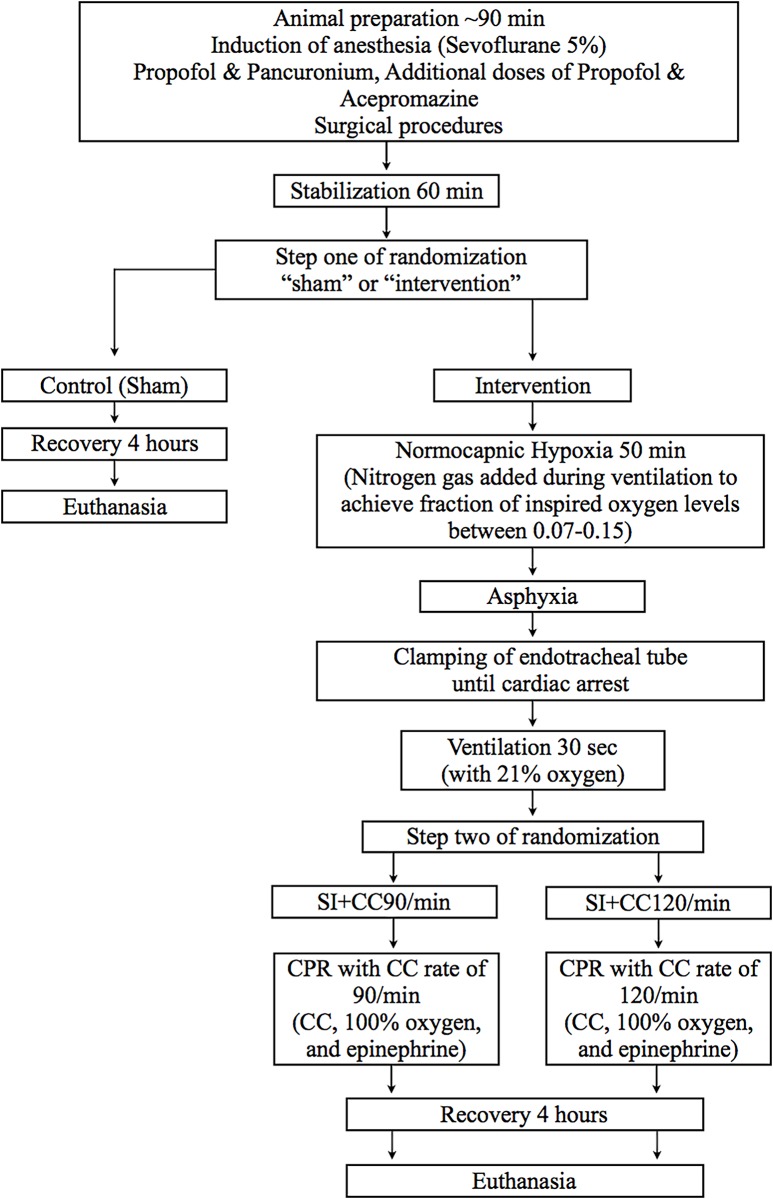
Study flow chart.